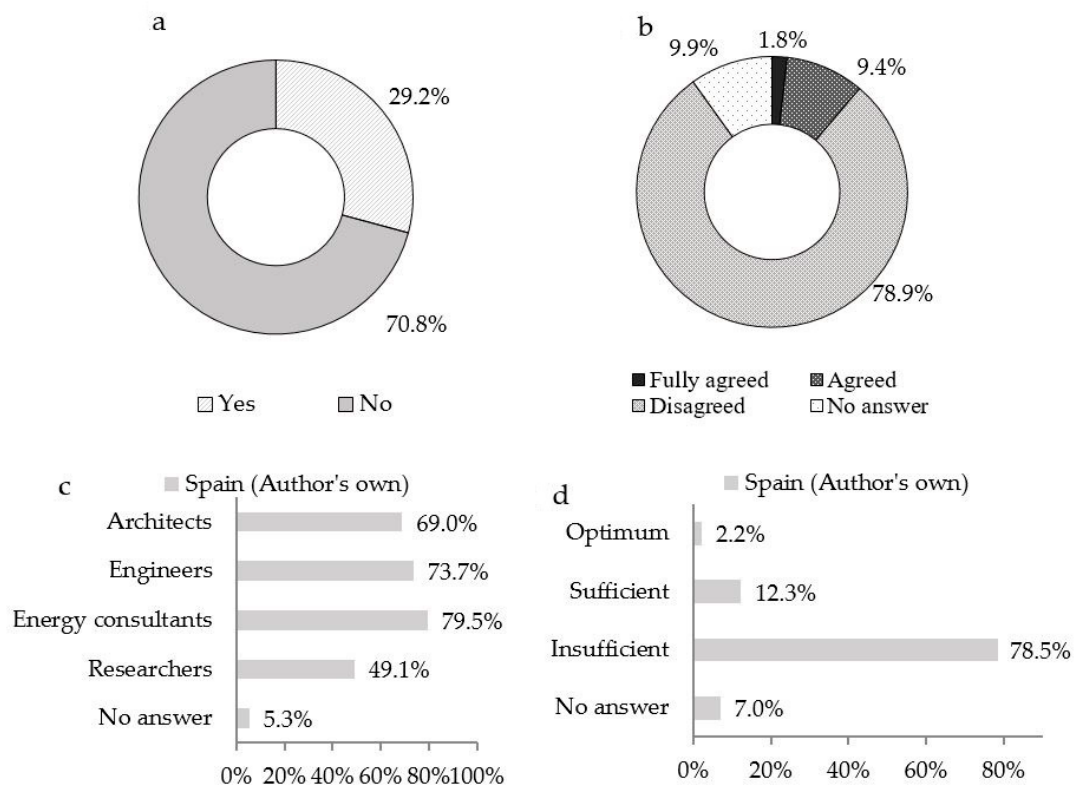
Figure 1. Analysis of the participants surveyed, according to their use of building performance simulation tools (BPSTs). ( a ) BPST Users and Non-users. Have you ever used BPSTs? ( b ) Building design can be substituted by quantitative simulation software; ( c ) The type of user who works with BPSTs; ( d ) Architects’ knowledge levels concerning BPSTs.